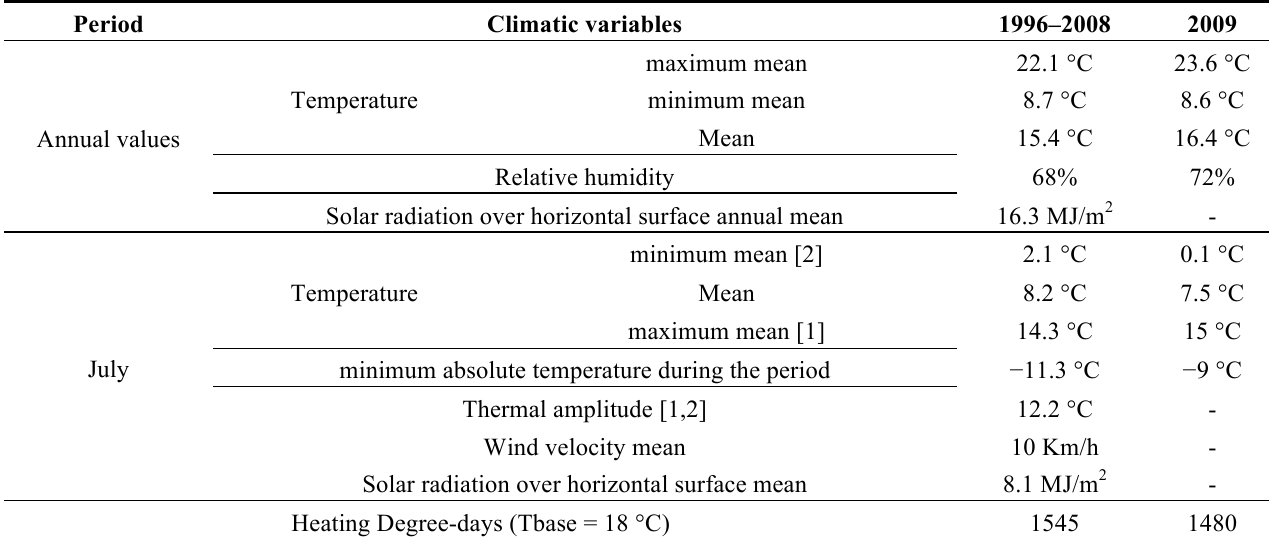
Table 1. Average of climatic variables during the period 1996–2008 and geographical location of Santa Rosa: Latitude: 36°57’; longitude: 64°27’ y height above sea level: 189 m